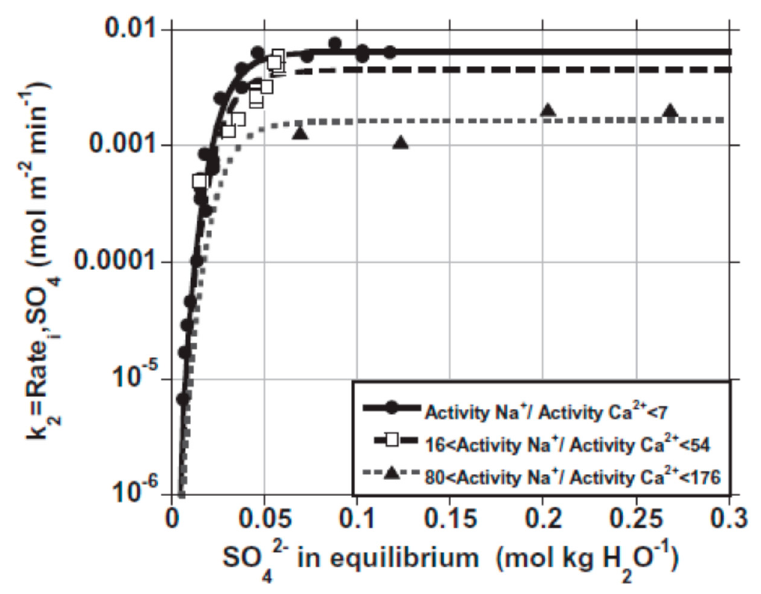
Figure 9. Change in the rate coefficient as a function of SO 4 2 − at equilibrium and Na + /Ca 2+ activity ratio. Experimental data (dots) are derived from [71,110,137,139]. Calculations (lines) are based on Equation (11). Reprinted from Reznik et al. [110] with permission from